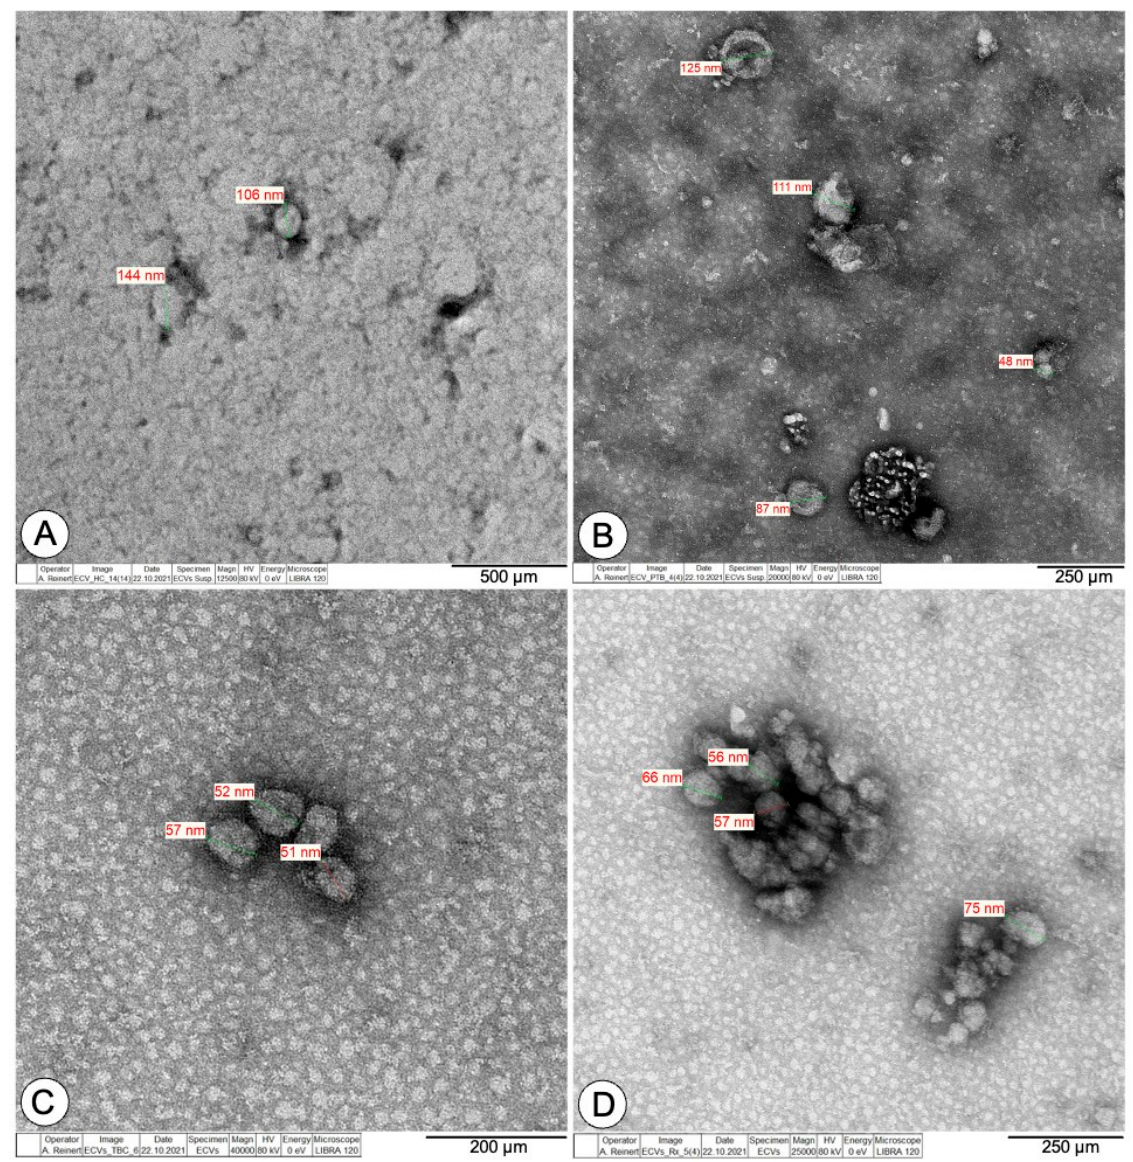
Figure 1. Transmission electron microscopy images of exosome isolates from blood plasma of healthy individuals ( A ), pulmonary tuberculosis ( B ), tuberculous lymphadenitis ( C ), and after anti-TB drug treatment ( D ). One representative picture out of at least three independent experiments is shown for each group.